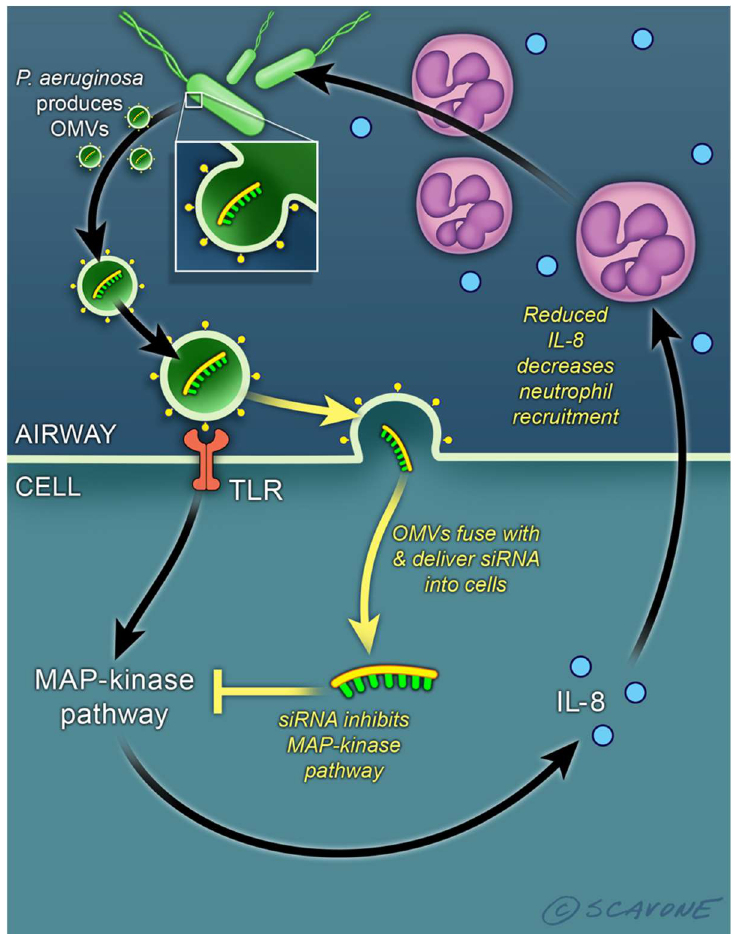
Figure 1. An sRNA (short RNA) secreted in OMVs (outer membrane vesicles) by P. aeruginosa sup- presses the host immune response. P. aeruginosa , residing in mucus overlying lung epithelial cells, secretes OMVs containing sRNA52320, a 23 nt tRNA fragment. OMVs fuse with cholesterol-rich lipid rafts in the apical membrane of airway epithelia cells, and deliver sRNA52320, which reduces the expression of several genes in the LPS stimulated MAPK pathway, thereby reducing IL-8 se- cretion and the migration of neutrophils into the lungs of mice [18,36,56,62]. Since neutrophils kill P. aeruginosa, it is proposed that the secretion of sRNA52320 in OMVs is a mechanism to reduce neutrophil mediated killing of P. aeruginosa, thereby enabling P. aeruginosa to establish/maintain chronic infection in immunocompromised individuals. 3. Extracellular Vesicles Secreted by Mammalian Cells are Important Mediators of Intercellular Communication and Delivery of miRNAs to Bacteria A few studies have demonstrated that eukaryotic miRNAs (~22 nt long) affect bacte- rial gene expression and phenotype [10–12,27,28]. Transfection of eukaryotic miRNAs into Fusobacterium nucleatum and E. coli affects mRNA abundance and bacterial growth in the gut [73]. The same research group also found that miR-30d given orally ameliorates auto- immune encephalomyelitis (EAE), a model of multiple sclerosis, by increasing Akkerman- sia muciniphila abundance in the gut, which leads to an increase in regulatory T cells that suppress EAE symptoms [74]. None of these studies, however, examined the ability of EVs to deliver miRNAs to bacterial cells. In a recent study, EVs secreted by primary hu- man airway epithelial cells were shown to deliver the miRNA let-7b-5p to P. aeruginosa [75]. Moreover, it was demonstrated that let-7b-5p reduced the formation of antibiotic re- sistant biofilms by decreasing the abundance of several proteins essential for biofilm for- mation [75] (Figure 2). The effect of let-7b-5p was inhibited by a let-7b-5p antagomir,